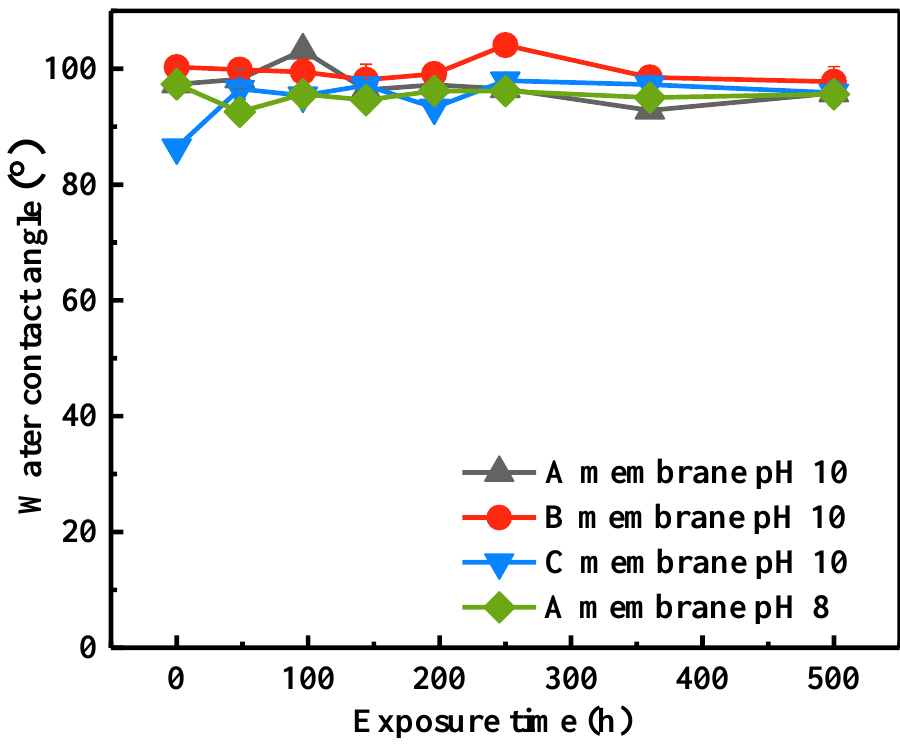
Figure 3. Water contact angles of the pristine and NaOCl ₋ exposed Membranes.